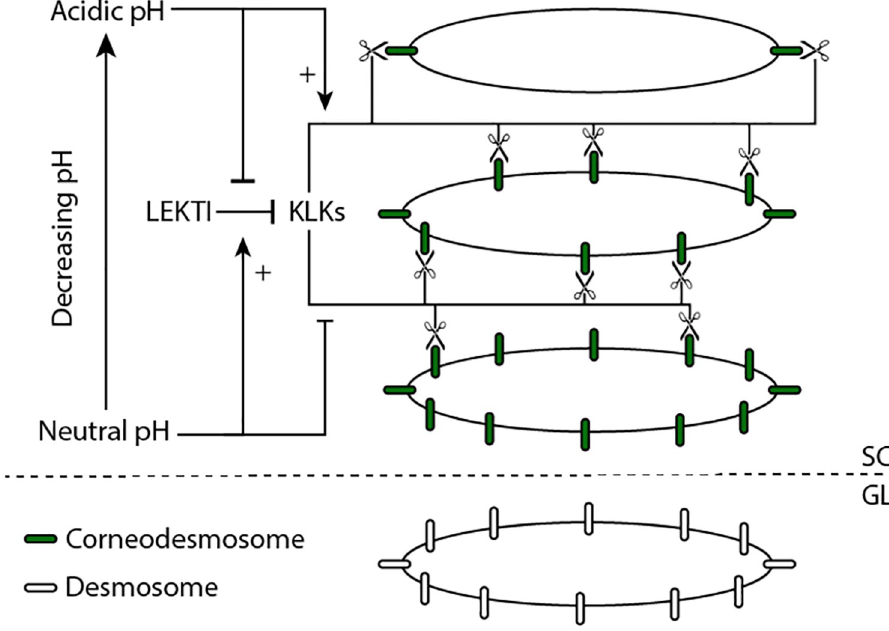
Fig 1. A diagram representing the involvement of pH, LEKTI, and KLKs in the desquamation process. Desmosomes (white ellipses) are converted to corneodesmosomes (green ellipses) as they enter the stratum corneum (SC in figure) from the granular layer (GL in figure). These corneodesmosomes are then degraded by KLKs, first on the horizontal surfaces then the vertical (indicated by the scissors). The degradation process is inhibited by LEKTI, which binds with the KLKs and stops the KLKs from binding with the corneodesmosomes. The local pH regulates the inhibition, and the corneodesmosome degradation rate by KLKs. Arrows with ‘+’ symbols indicate the pH increases the reaction, while ‘ ⟞ ’ indicates the pH reduces the rate of the